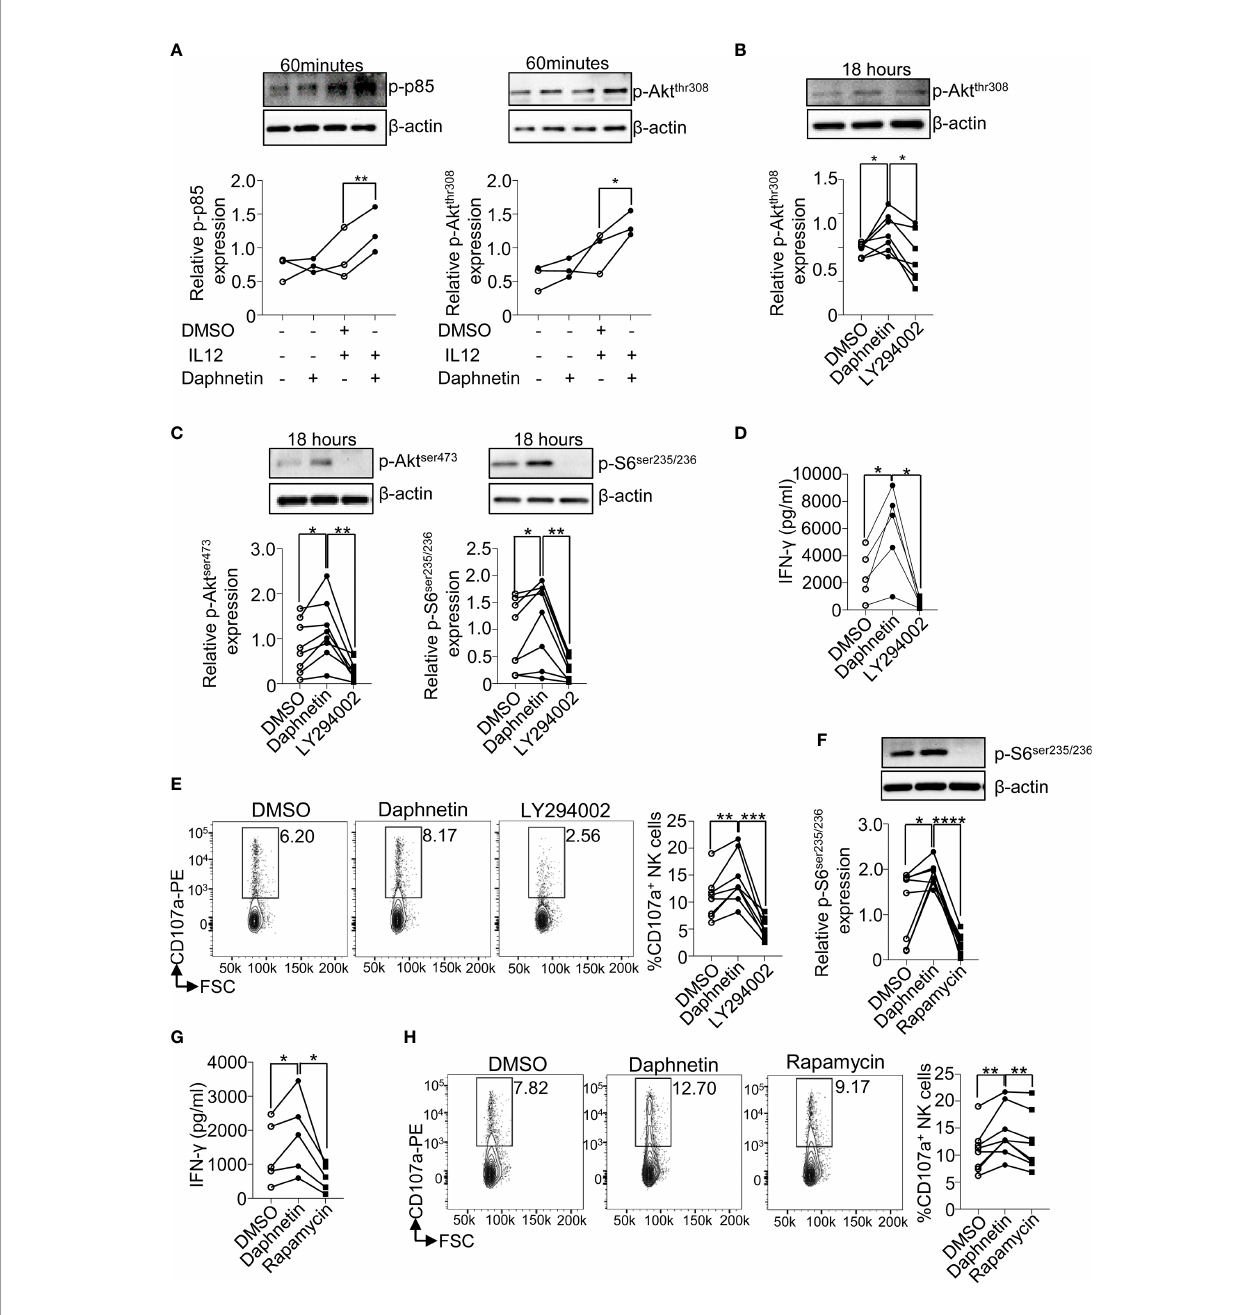
FIGURE 5 | PI3K-mTOR pathway participates in the signal network of Daphnetin-activated NK cells. (A) Puri fi ed human primary NK cells were treated with DMSO, Daphnetin (10 m M), IL-12 (10 ng/ml), or Daphnetin plus IL-12 for 60 min. The protein levels of p-p85 (left) and p-Akt thr308 (right) in NK cells were determined by immunoblotting. (B – D) Puri fi ed human primary NK cells were treated with DMSO or LY294002 (10 m M) in the presence of IL-12 (10 ng/ml) and Daphnetin (10 m M) for 18 h The protein levels of p-Akt thr308 (B) , p-Akt ser473 ( C , left), and p-S6 ser235/236 ( C , right) in NK cells were determined by immunoblotting, and IFN- g secretion in the supernatants of cell culture (D) was determined by ELISA, respectively. (E) Puri fi ed human primary NK cells were treated with DMSO or LY294002 (10 m M) in the presence of IL-12 (10 ng/ml) and Daphnetin (10 m M) for 18 h, and then co-cultured with K562 cells for another 6 h, and the expression level of CD107a on NK cells was determined by FACS. (F, G) Puri fi ed human primary NK cells were treated with DMSO or rapamycin (1 nM) in the presence of IL-12 (10 ng/ml) and Daphnetin (10 m M) for 18 h The protein level of p-S6 ser235/236 (F) and IFN- g secretion in the supernatants of cell culture (G) were determined by immunoblotting and ELISA, respectively. (H) Puri fi ed human primary NK cells were treated with DMSO or rapamycin (1 nM) in the presence of IL-12 (10 ng/ml) and Daphnetin (10 m M) for 18 h, and then co-cultured with K562 cells for another 6 h and the expression level of CD107a on NK cells was determined by FACS. Paired t -test for (A – H) . * p < 0.05, ** p < 0.01, *** p < 0.001,**** p < 0.0001 (A – H)